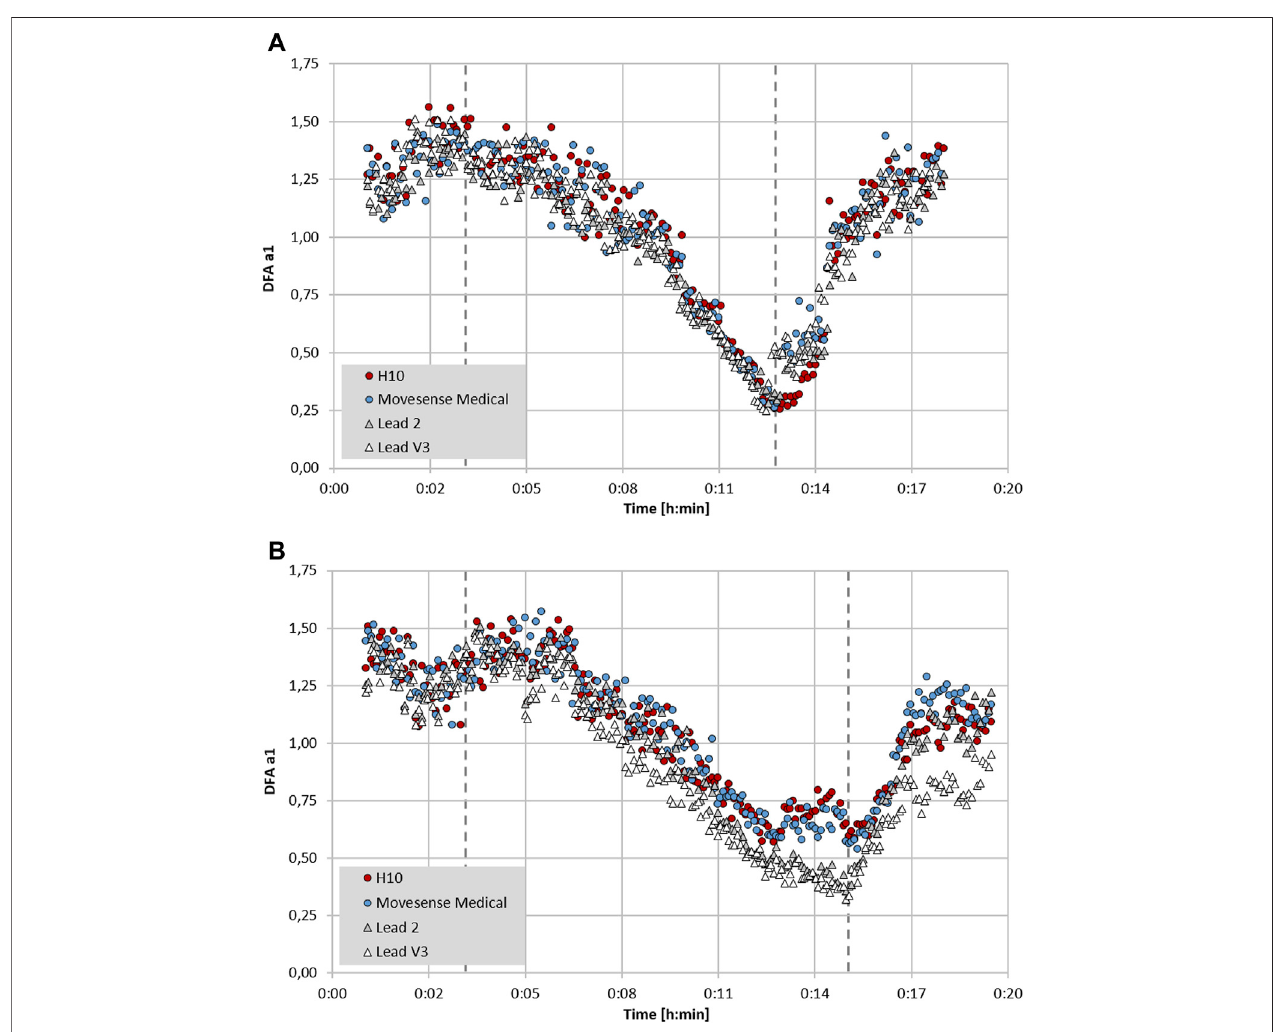
FIGURE3| PlotofDFAa1overtimeduringthecourseofanincrementalcyclingramptestuntilvoluntaryexhaustion,including3 minofwarm-upat50Wand5 min cool-down of unloaded pedalling (dashed lines mark the start of the incremental test and voluntary exhaustion), with two participants wearing a 12 channel ECG CardioPart 12 Blue (AMEDTEC Medizintechnik Aue GmbH, Aue, Germany; sampling rate: 500 Hz), Polar H10 chest belt (Polar Electro Oy, Kempele, Finland; sampling rate: 1,000 Hz) and Movesense Medical sensor single channel ECG chest belt (Movesense, Vantaa, Finland; sampling rate: 512 Hz). (A) Participant 1 with similar DFA a1 seen in both chest belt devices and lead 2 and V3 of the 12 channel ECG. (B) Participant 2 with discrepancy between DFA a1 in both chest belt devices comparedtolead 2and V3ofthe 12channel ECG.All data analyzed with KubiosHRVPremium softwareVersion3.5 ( “ time varying ” option: window width of2 min, grid interval of 5 s) (data and plot adapted from Rogers et al.,